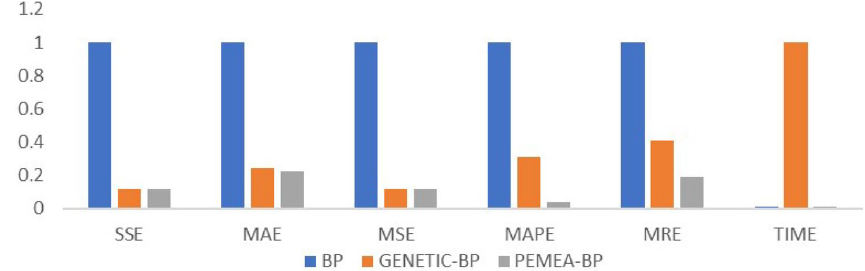
Figure 5. Normalized fitting accuracy chart.